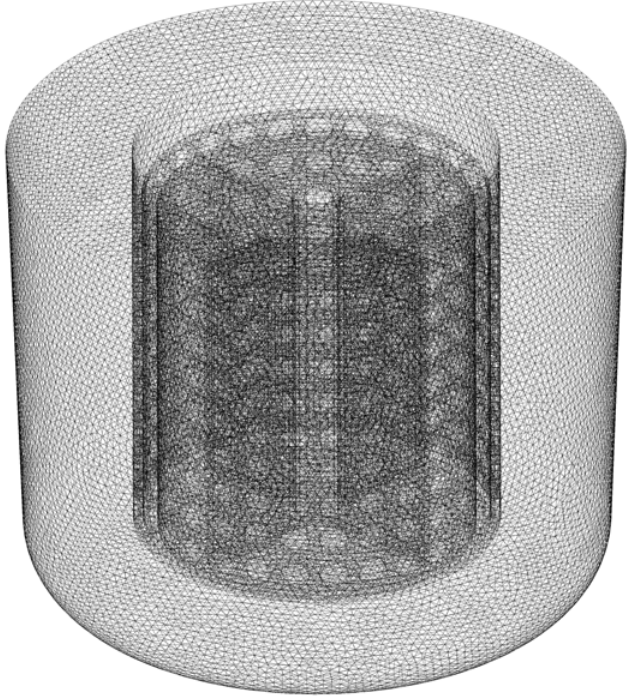
Figure 2. Grid distribution in the stirred tank.